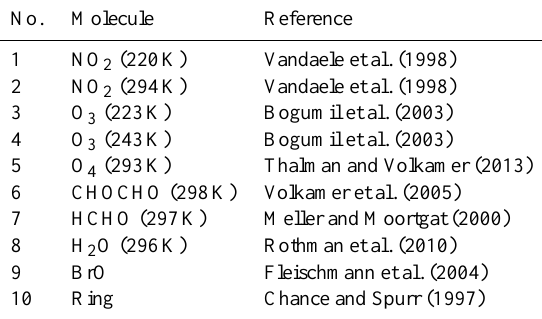
Table 2. Configuration of the instrument during the MAD-CAT setup.